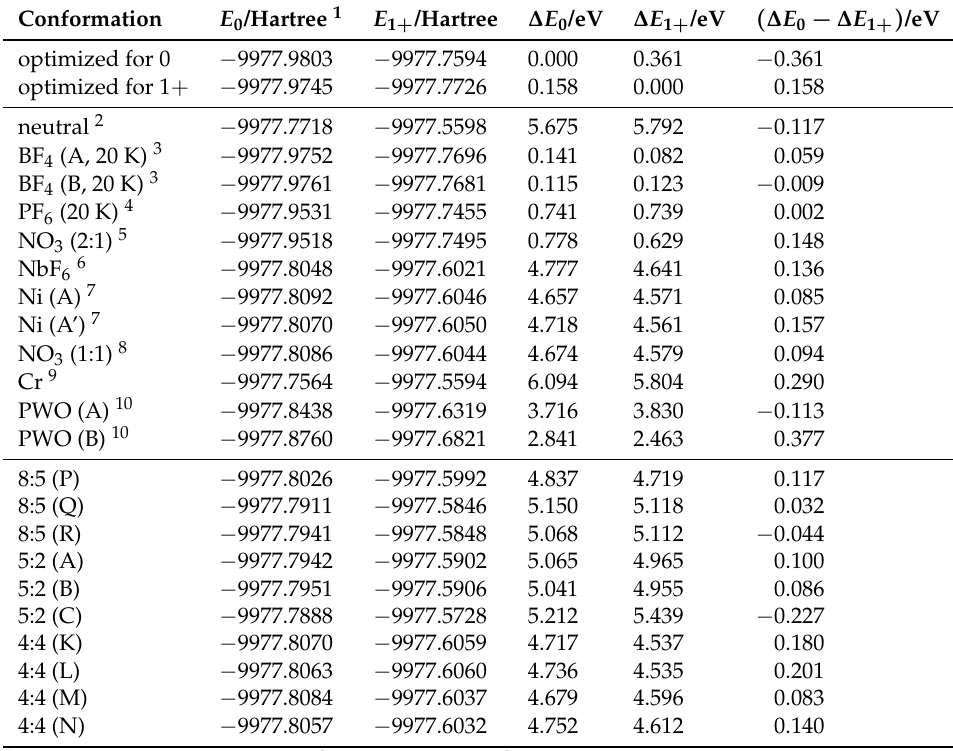
Table 4. The total energies of TMTSF molecules at neutral and cationic states ( E 0 and E 1 + ); their relative values with respect to those calculated for the optimized structures ( ∆ E 0 = E 0 − E 0 ( optimized for 0 ) and ∆ E 1 + = E 1 + − E 1 + ( optimized for 1 +) ); and their difference ( ∆ E 0 − ∆ E 1 + ) as a measure of the valence of each conformation of TMTSF molecule. The E 0 and E 1 + were obtained by Hartree–Fock (HF) calculations (6-31G(d,p)) followed by Møller–Plesset correlation energy calculations truncated at second order (MP2)